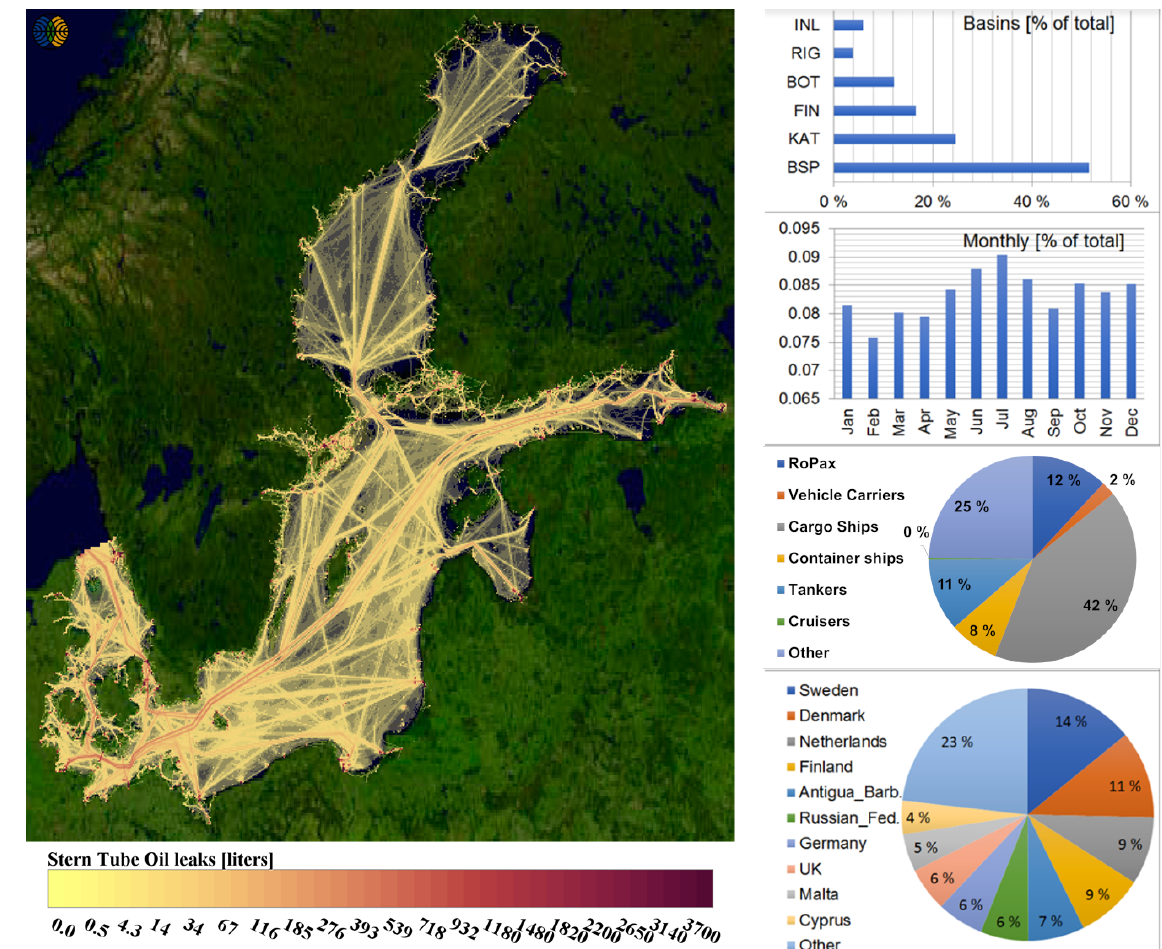
Figure 4. Distribution of the annual stern tube oil releases for the year 2012 from the Baltic Sea shipping. Discharge volumes are indicated in litres per map grid area of 5km 2 . Top right: share of stern tube oil released in various sub-basins of the Baltic Sea (INL: inland areas; RIG: Gulf of Riga; BOT: Bothnian Bay and Bothnian Sea; FIN: Gulf of Finland; KAT: Kattegat; BSP: Baltic Sea proper). The lower bar chart depicts the monthly variation in stern tube oil discharges. The upper pie chart summarises the contribution of various ship types to stern tube oil releases and the lower pie chart the flag state shares of stern tube oil releases. Map: background Landsat-8 image courtesy of the US Geological